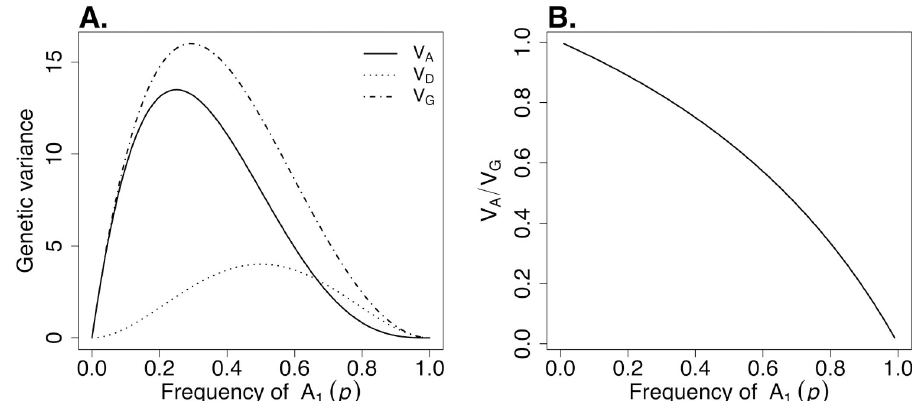
Fig 1. Numerical example for a single locus model with genotypic value a = 4 for the homozygote A 1 A 1 and complete dominance of A 1 ( d = 4). Distributions of (A) additive (V A ), dominance (V D ), and total (V G ) genotypic variance and (B) proportion of genotypic variance explained by additive variance (V A /V G ).